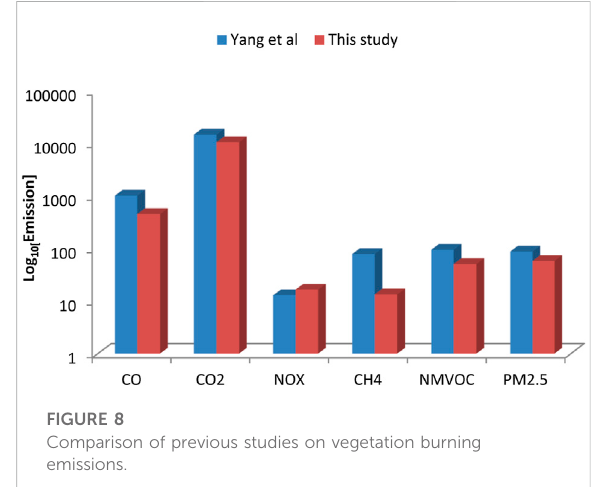
FIGURE 8 Comparison of previous studies on vegetation burning